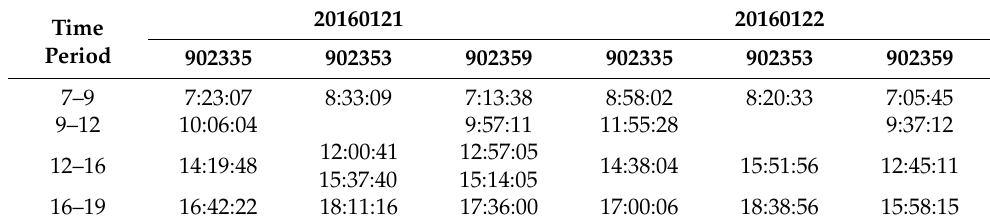
Table 2. Departure time of 3 drivers predicted in data set